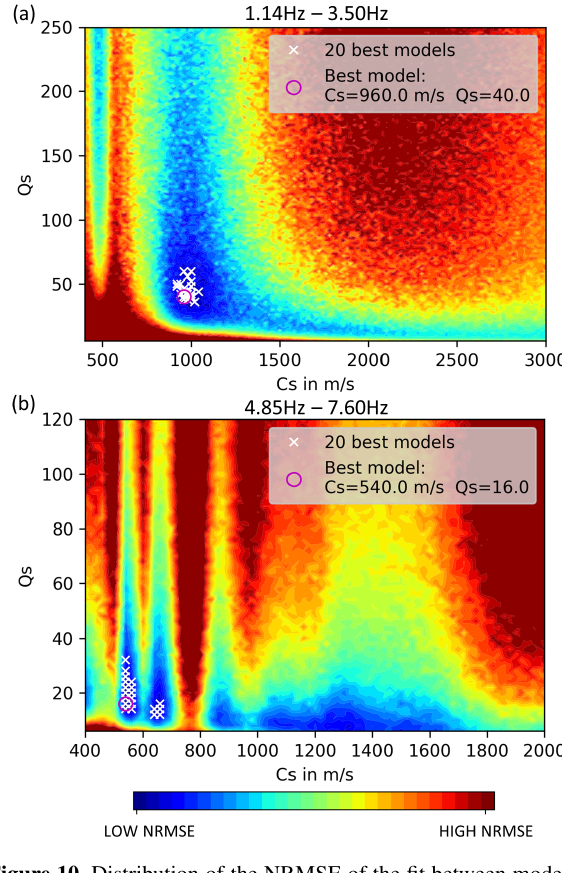
Figure 10. Distribution of the NRMSE of the fit between modeled and observed amplitude decays obtained by a Q S – c S grid search. The 20 best models (white cross) and the very best model (magenta circle) that fit amplitude decays of signals with (a) 1.14, 1.69, 2.26, and 3.50Hz and (b) 4.85, 5.98 and